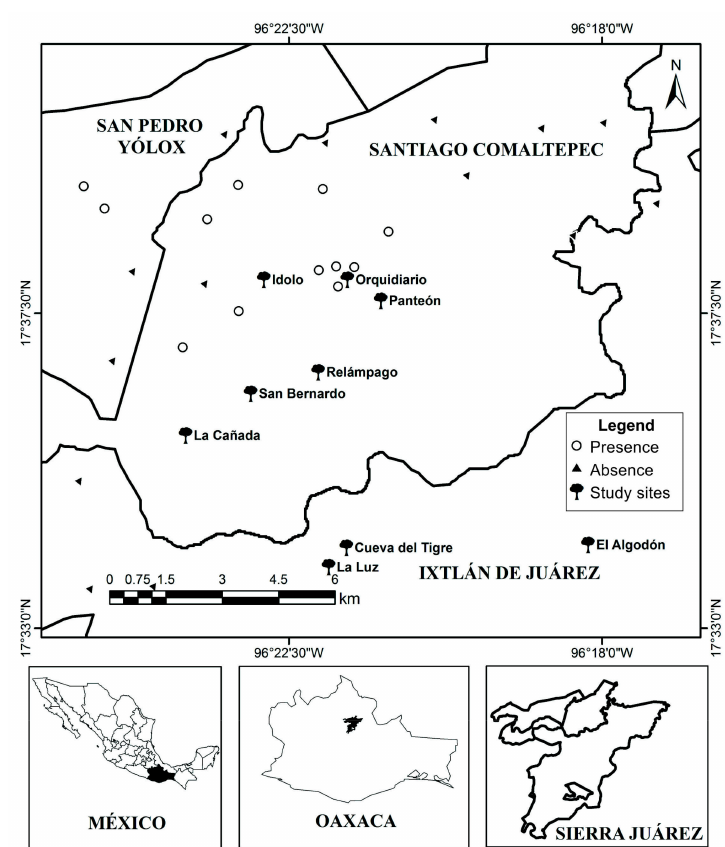
Figure 2. Location of O. mexicana populations in the Sierra Ju á rez in Oaxaca, Mexico. Black tree indicates the nine ecological study sites, white circle indicates sites with presence of the species and black triangle indicate absence of O. mexicana in three municipalities in the Sierra Ju á